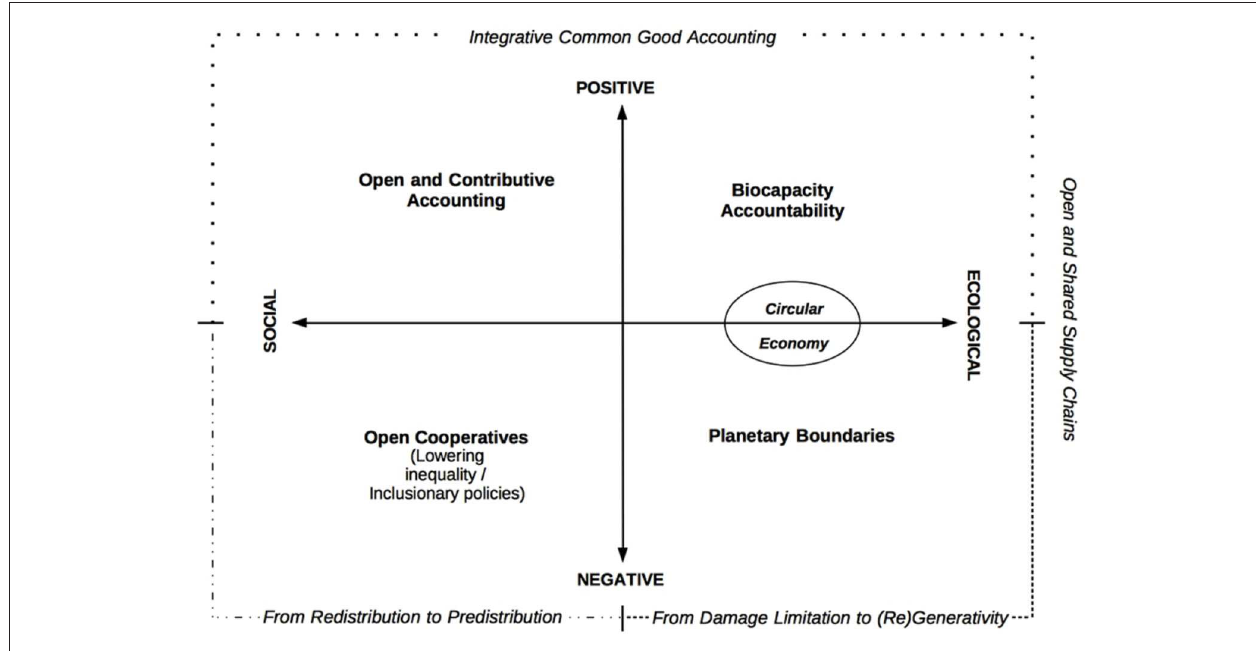
FIGURE 7 | Four kinds of externalities (used with permission. Graphic by Michel Bauwens. To be published in upcoming report by P2P Foundation: P2P Accounting for Planetary Survival, 2019,